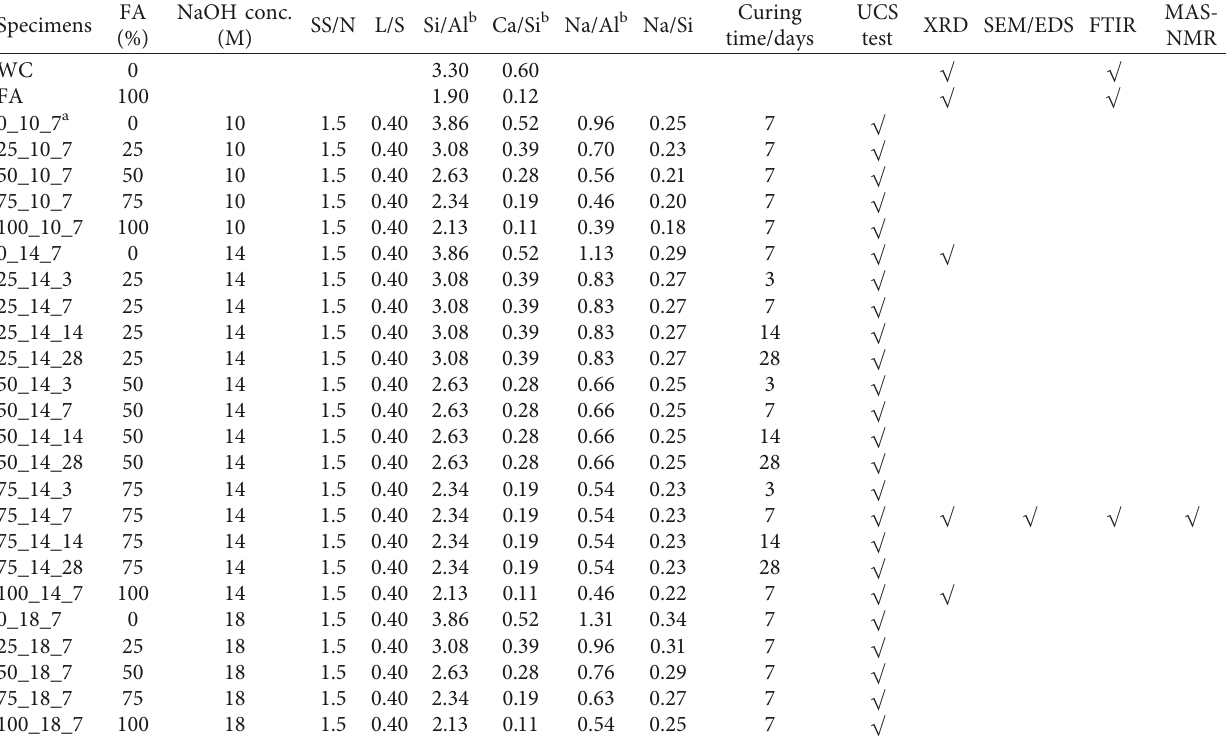
Table 2: Variables and conducted tests on WC/FA